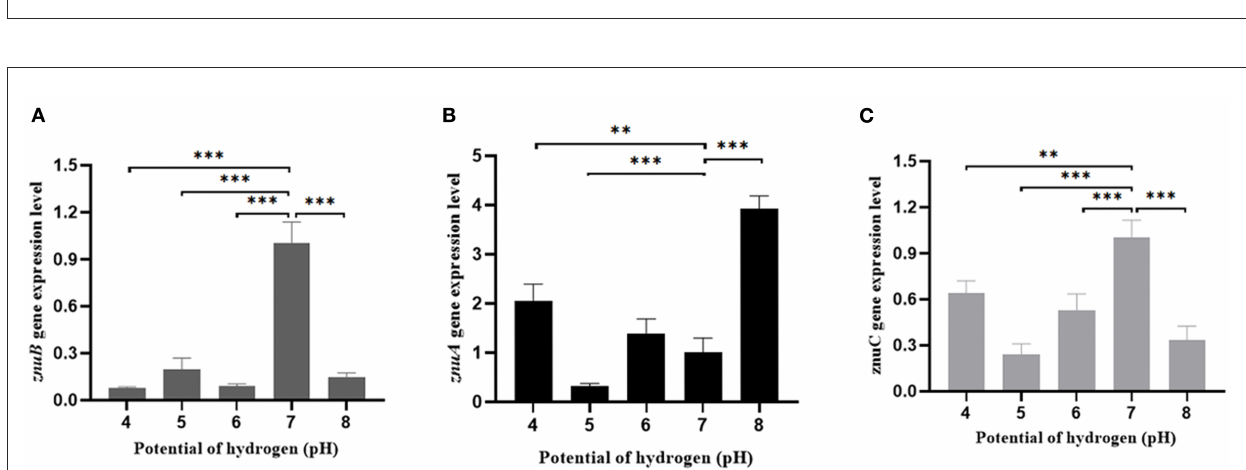
FIGURE8 The expression levels of znuA , znuB, and znuC under different temperature. (A) was the expression levels of znuA at 18, 28, and 37 ◦ C; (B) was the expression levels of znuB at 18, 28, and 37 ◦ C; (C) was the expression levels of znuC at 18, 28, and 37 ◦ C. Data were presented as mean ± standard deviation (SD) ( n = 3). *** P < 0.001.